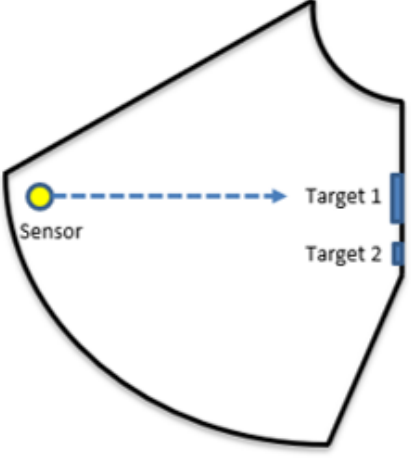
Figure 13. Laboratory layout.